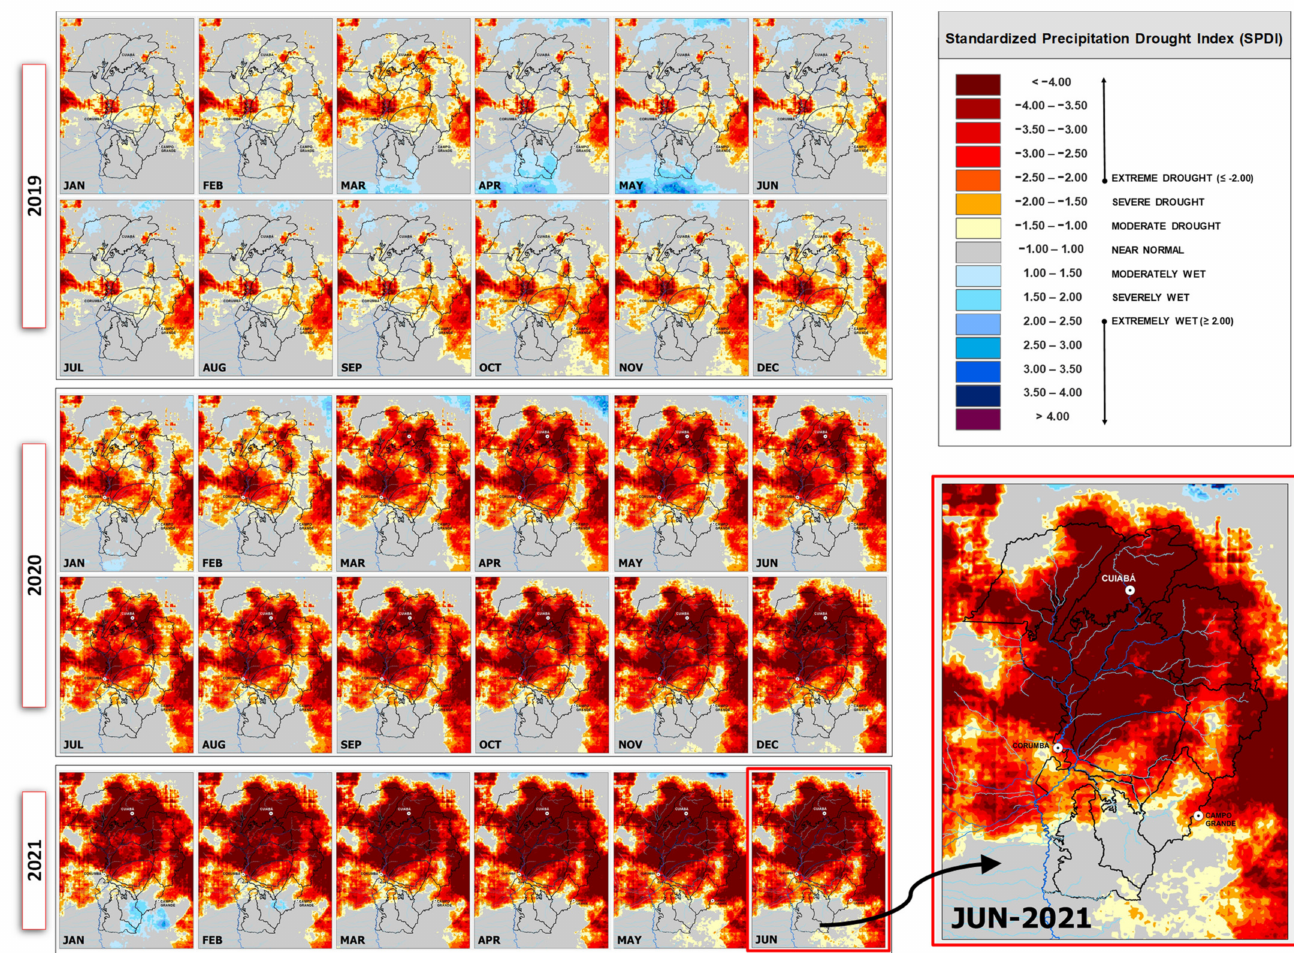
Figure 6. Spatial-temporal dynamics of the Standardized Precipitation Drought Index (SPDI) from January 2019 to June 2021 at the of the Upper Paraguay River Basin (UPRB) encompassing the Pantanal and the surrounding Highlands. Sub-regions are described in Figure 1. SPDI categories were adapted from McKee et al. [34] and WMO